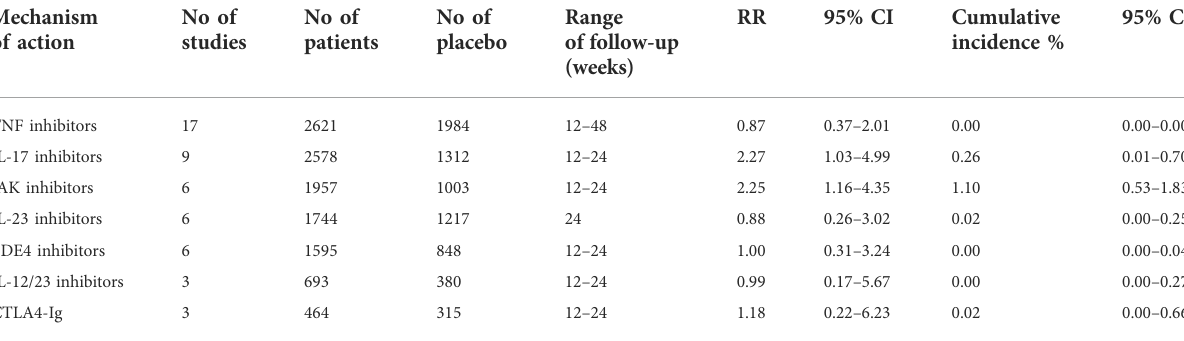
RR 95% CI Cumulative